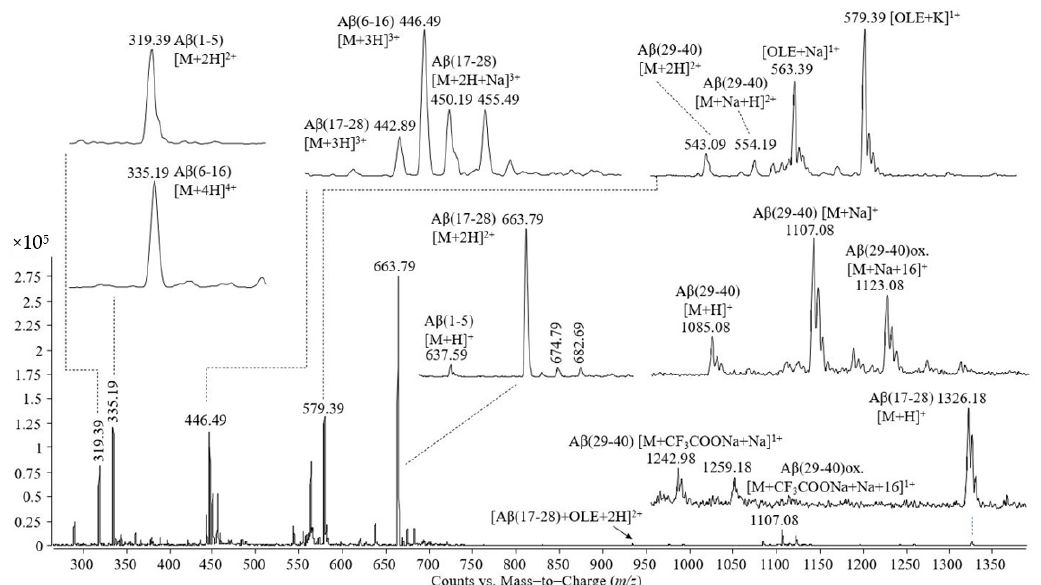
Molecules 2021 , 26 , x FOR PEER REVIEW Figure 4. Mass spectrum obtained by ESI-triple quadrupole analysis of A β (1–40), proteolitically cleaved by trypsin.